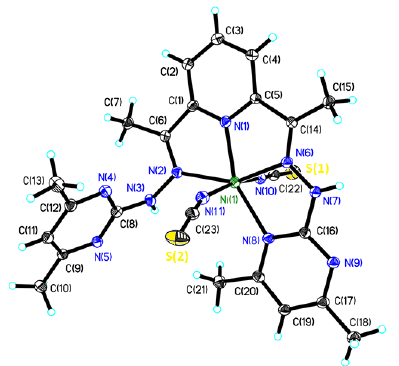
Figure 4. Molecular structure and atom-numbering scheme of compound 4 .